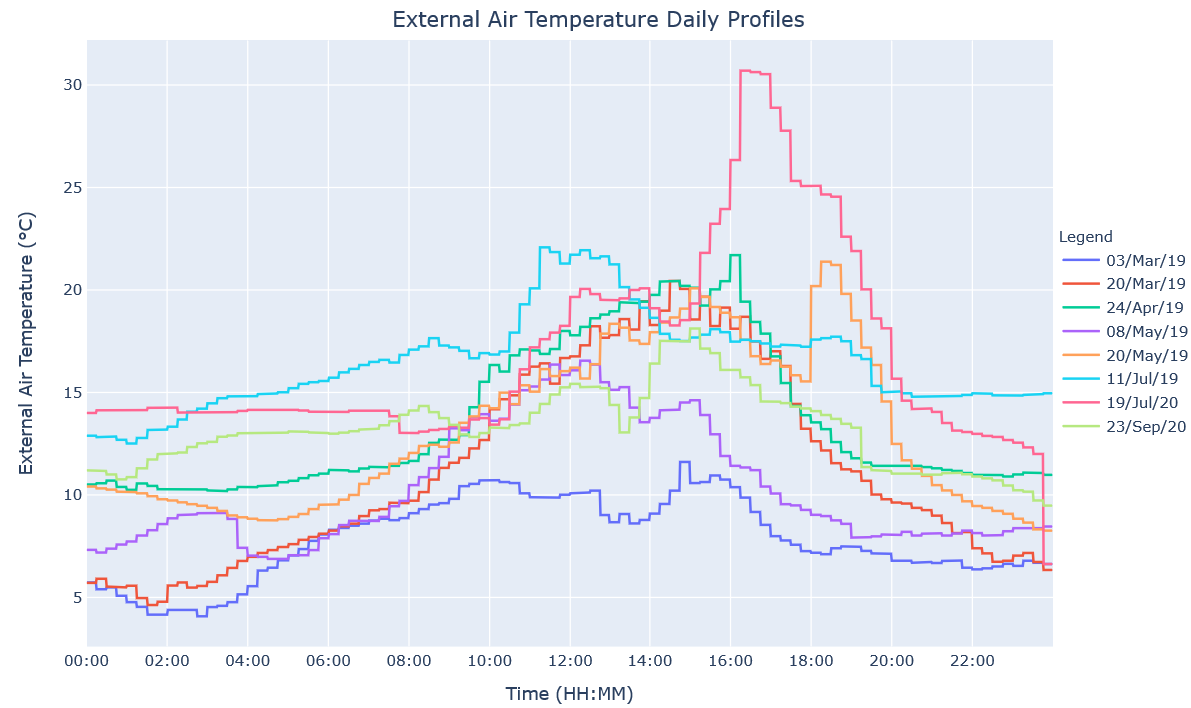
Figure 2. Overview of external air temperature daily profiles from the site’s BMS, for each day on which a grid frequency event occurred.